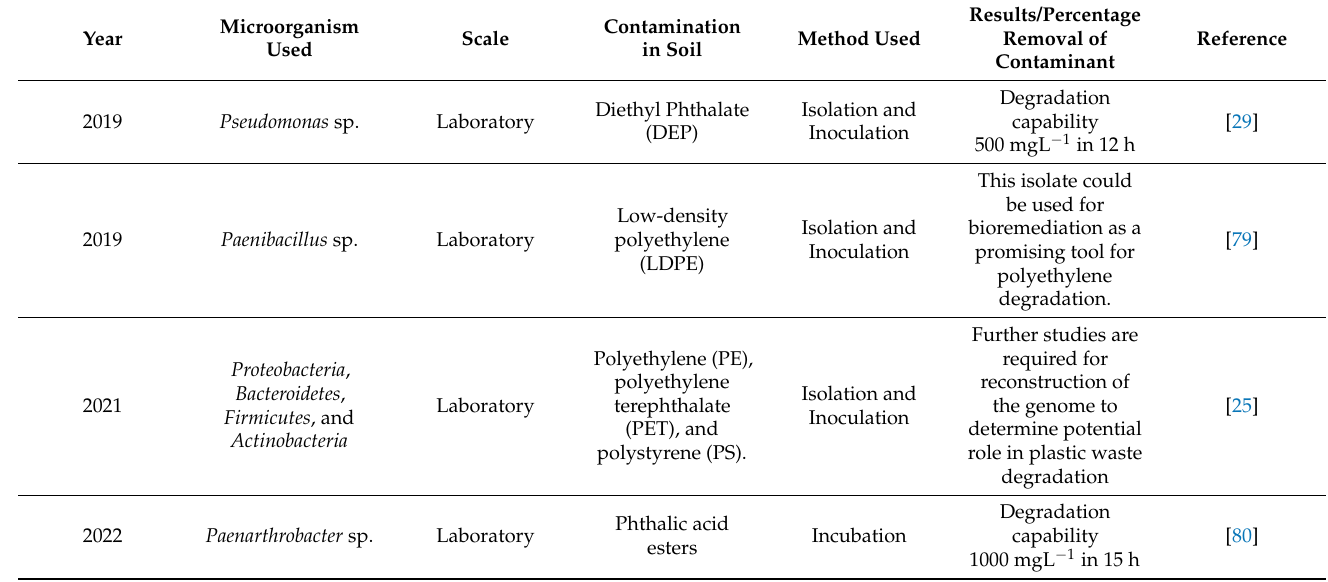
Table 3. The removal rate of polymers and